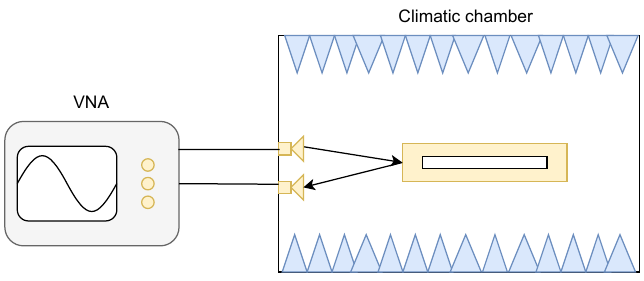
Figure 1. Principle of the measurement of the scatterer’s resonance frequency used to sense tempera- ture and humidity. The climatic chamber allows the control of both temperature and humidity values.